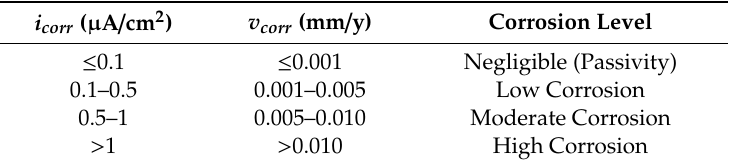
Table 8. Ranges of corrosion current density ( i corr ), and the corrosion rate ( v corr ) related to corrosion level [87].